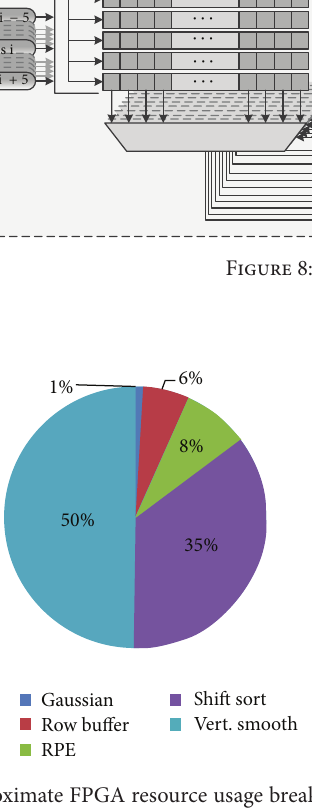
Figure 9: Approximate FPGA resource usage breakdown by block for the profile shape matching hardware